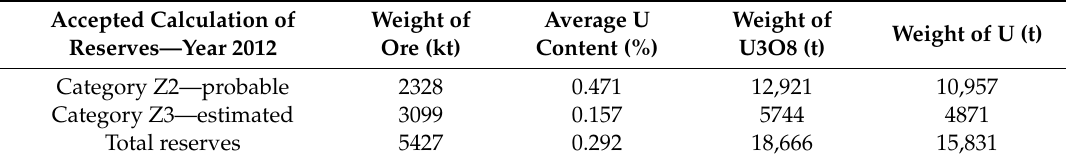
Table 4. The reserves of mineral raw materials are classified according to the degree of examination of the exclusive deposit Kuriskova [61].